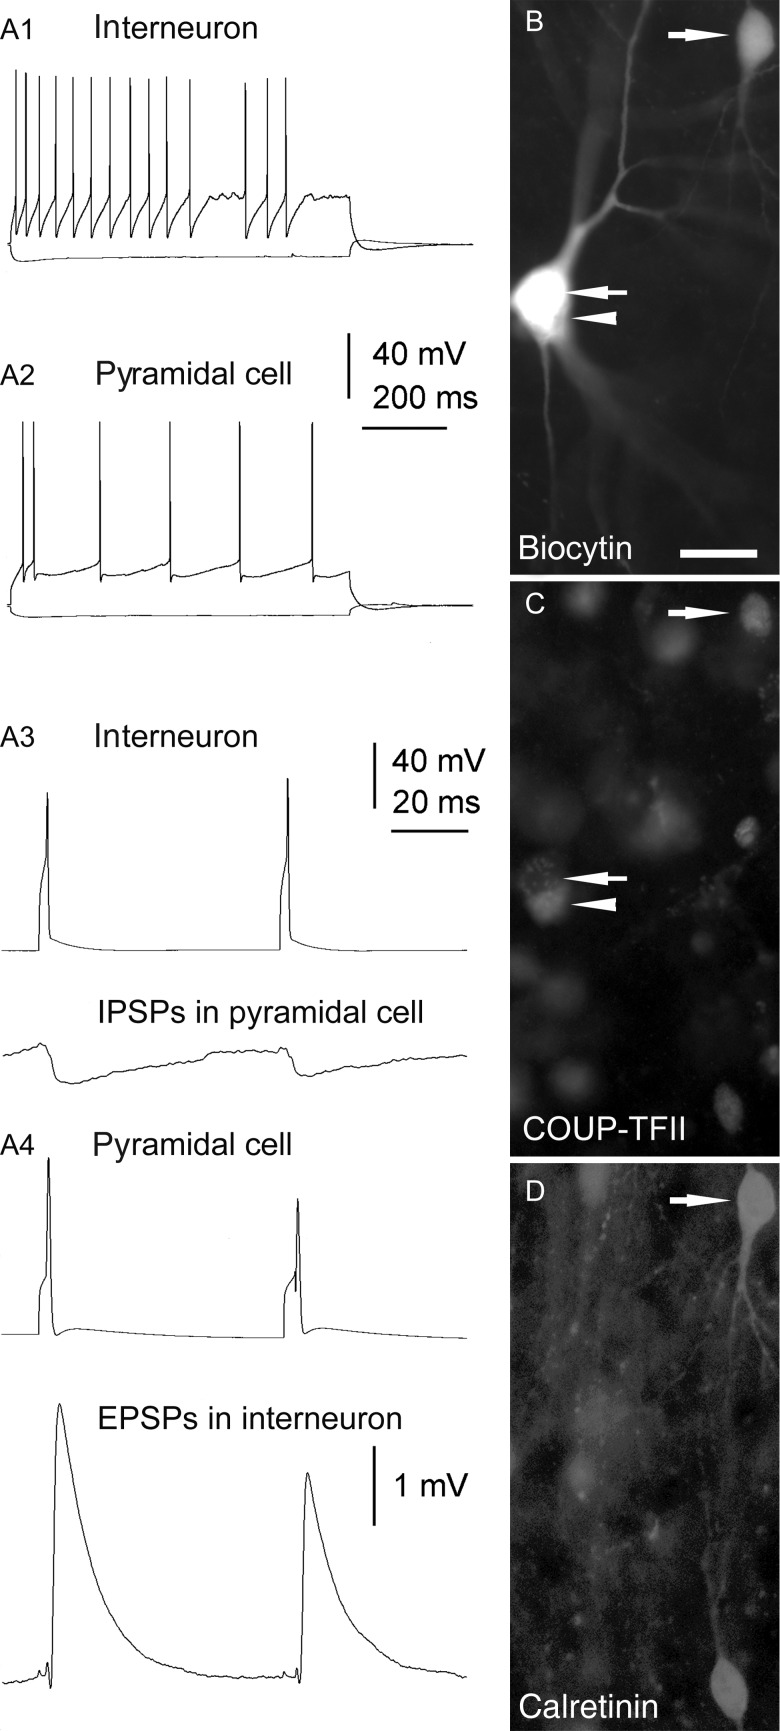
Reciprocal synaptic connections between a calretinin-/COUP-TFII-positive interneuron and a pyramidal cell in layer II. (A1 and A2) AP patterns of the 2 neurons in response to depolarizing (top traces) or hyperpolarizing (bottom traces) current steps. (A3 and A4) APs of the interneuron (A3, top trace) or the pyramidal cell (A4, top trace) elicit IPSPs (A3, bottom trace) or EPSPs (A4, bottom trace), respectively, in the postsynaptic cell. IPSPs and EPSPs are averages of 20 sweeps. (B) The biocytin filled interneuron (upper right corner) and pyramidal cell (arrow). (C) The nucleus of the interneuron, but not that of the pyramidal cell, is immunopositive for COUP-TFII. Arrowhead points to a COUP-TFII-positive interneuron in close apposition to the pyramidal cell. Note weak cytoplasmic autofluorescence in the pyramidal cell. (D) The interneuron as well as another COUP-TFII-positive cell (open arrow) are immunopositive for calretinin. Scale bar: 20 µm.